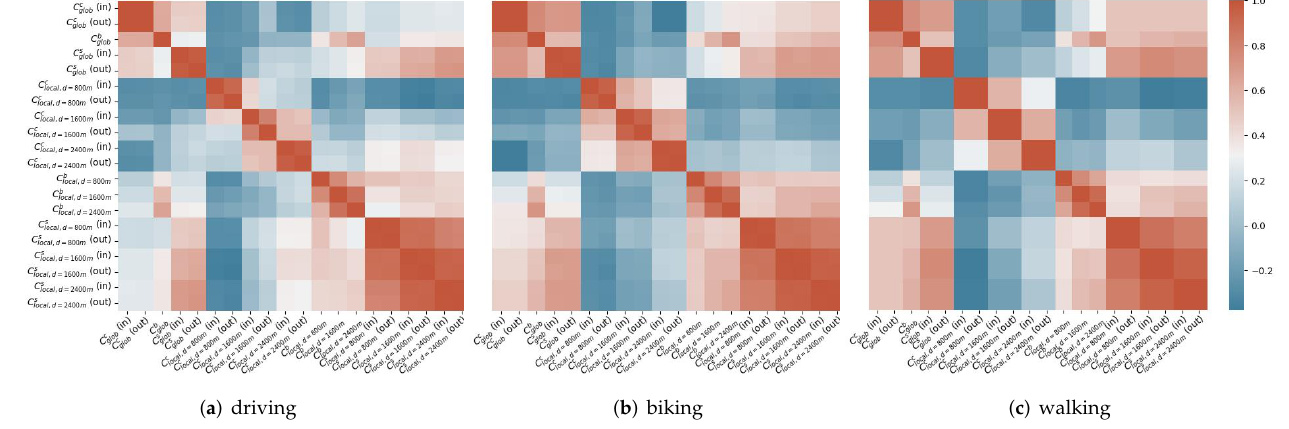
Figure 7. New York City: Pair-wise correlation between different centrality measures when con- sidering the road network as a directed graph. The color bar on the right side shows the range of correlation coefficients with the highest as 1 and the lowest as − 0.4 per our